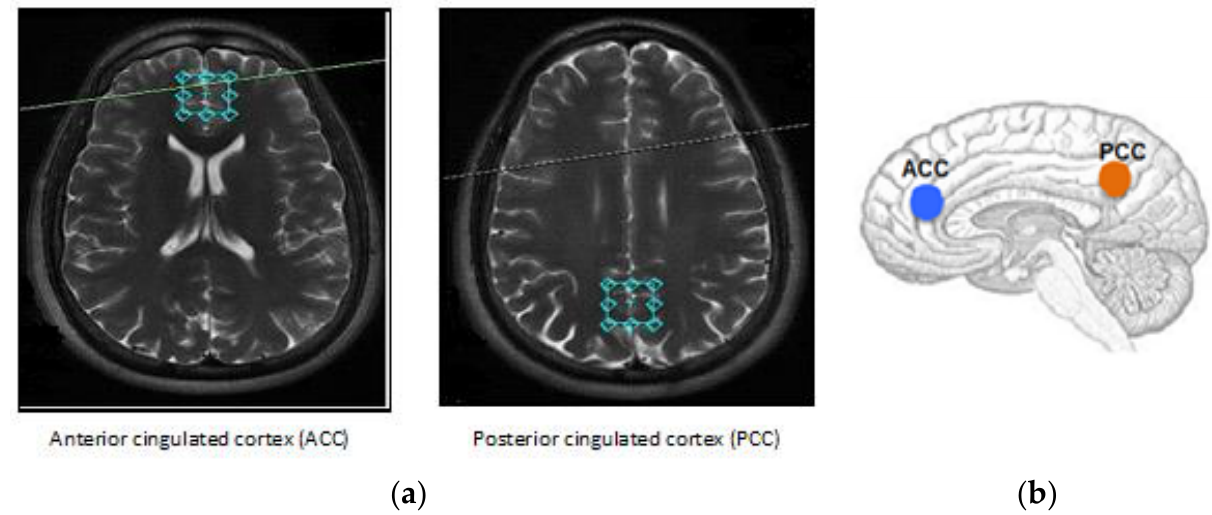
Figure 1. Locations of the volume studied in the ( a ) anterior and ( b ) posterior cingulated cortices. The single voxel acquisition used a spin-echo sequence recorded within the following parameters: Echo time (TE) = 23 ms, repetition time (TR) = 1070 ms, 2 NEX, flip angle = 90 ◦ , and 256 acquisitions with the point-resolved spectroscopy (PRESS) technique. During data acquisition, the same experienced neuroradiologist, blind to the clinical data, placed the voxels (20 × 20 × 20 mm 3 ) at the ACC and PCC.